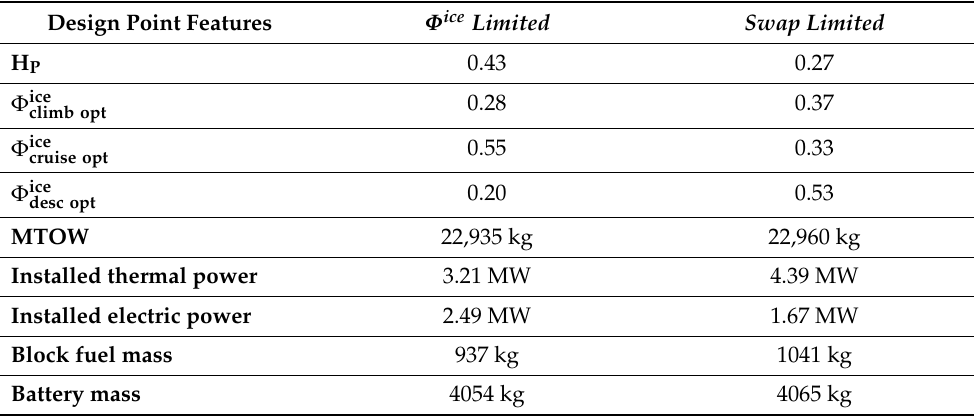
Table 5. Hybrid-electric aircraft main